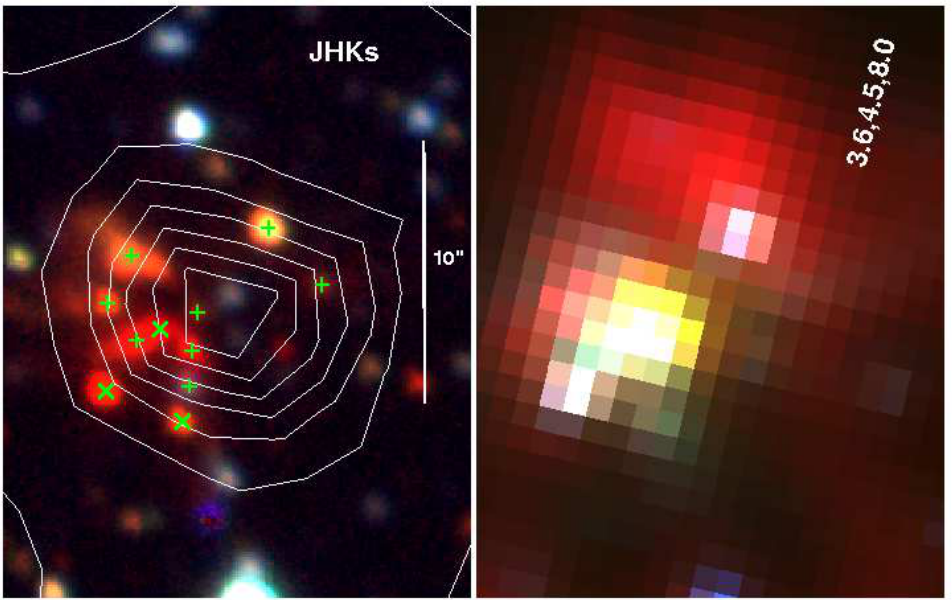
Figure 2: ( Left panel) JHKs color-coded image of IRAS19388+2375 obtained combining the J (blue), H (green), and Ks (red) individual images The contours show the 70 µ m Herschel observation. The symbol (+) marks the positions of the sources with near-IR excess, while the crosses indicate sources not detec- tect in J but with H-Ks greater than 3( Right panel) Color-coded Spitzer image obtained combining the [3.6] (blue), [4.5] (green), and [8.0] µ m (red) individual IRAC images. The central position of the two images is